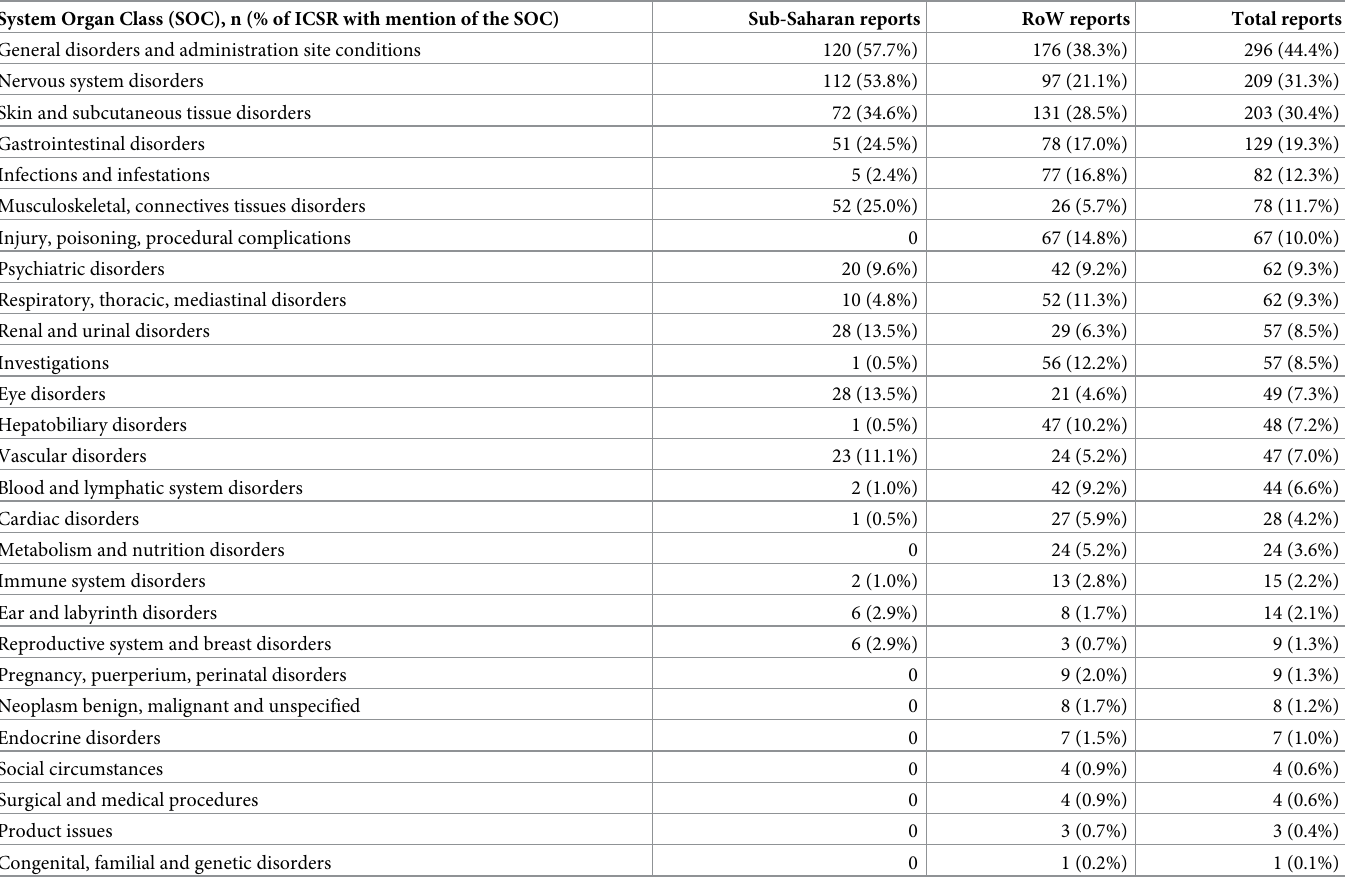
Table 3. Frequency of reported SOC by regions and in total. Multiple SOC can be reported in a single ICSR. System Organ Class (SOC), n (% of ICSR with mention of the